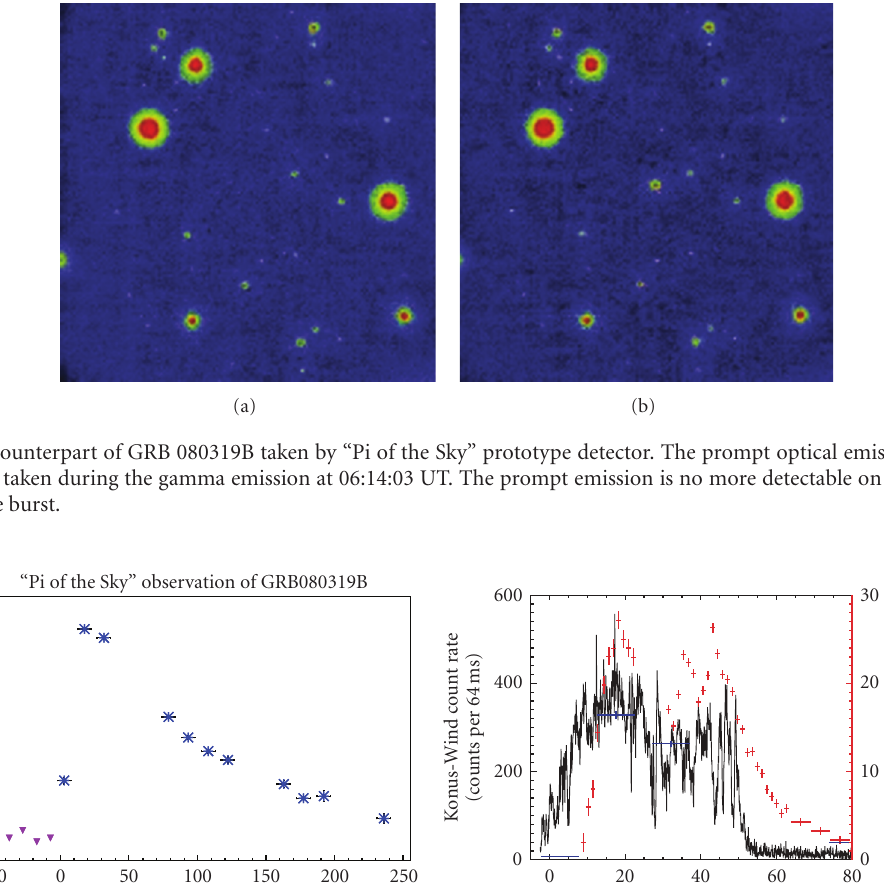
observed this area for more than 23 minutes before the burst, pointing to the first GRB position. 2 seconds before BAT